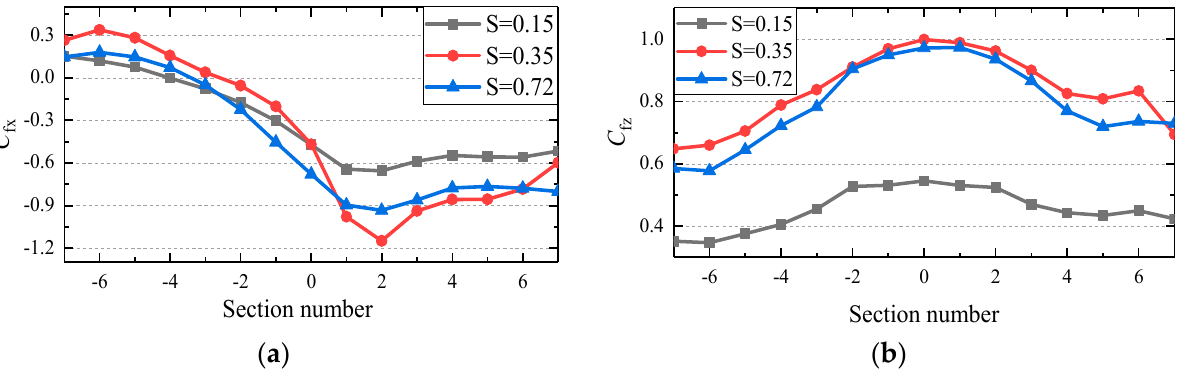
Figure 16. Variations in mean sectional aerodynamic load coefficients across car with swirl ratio ( λ = 0). ( a ) C fx ; ( b ) C fz .